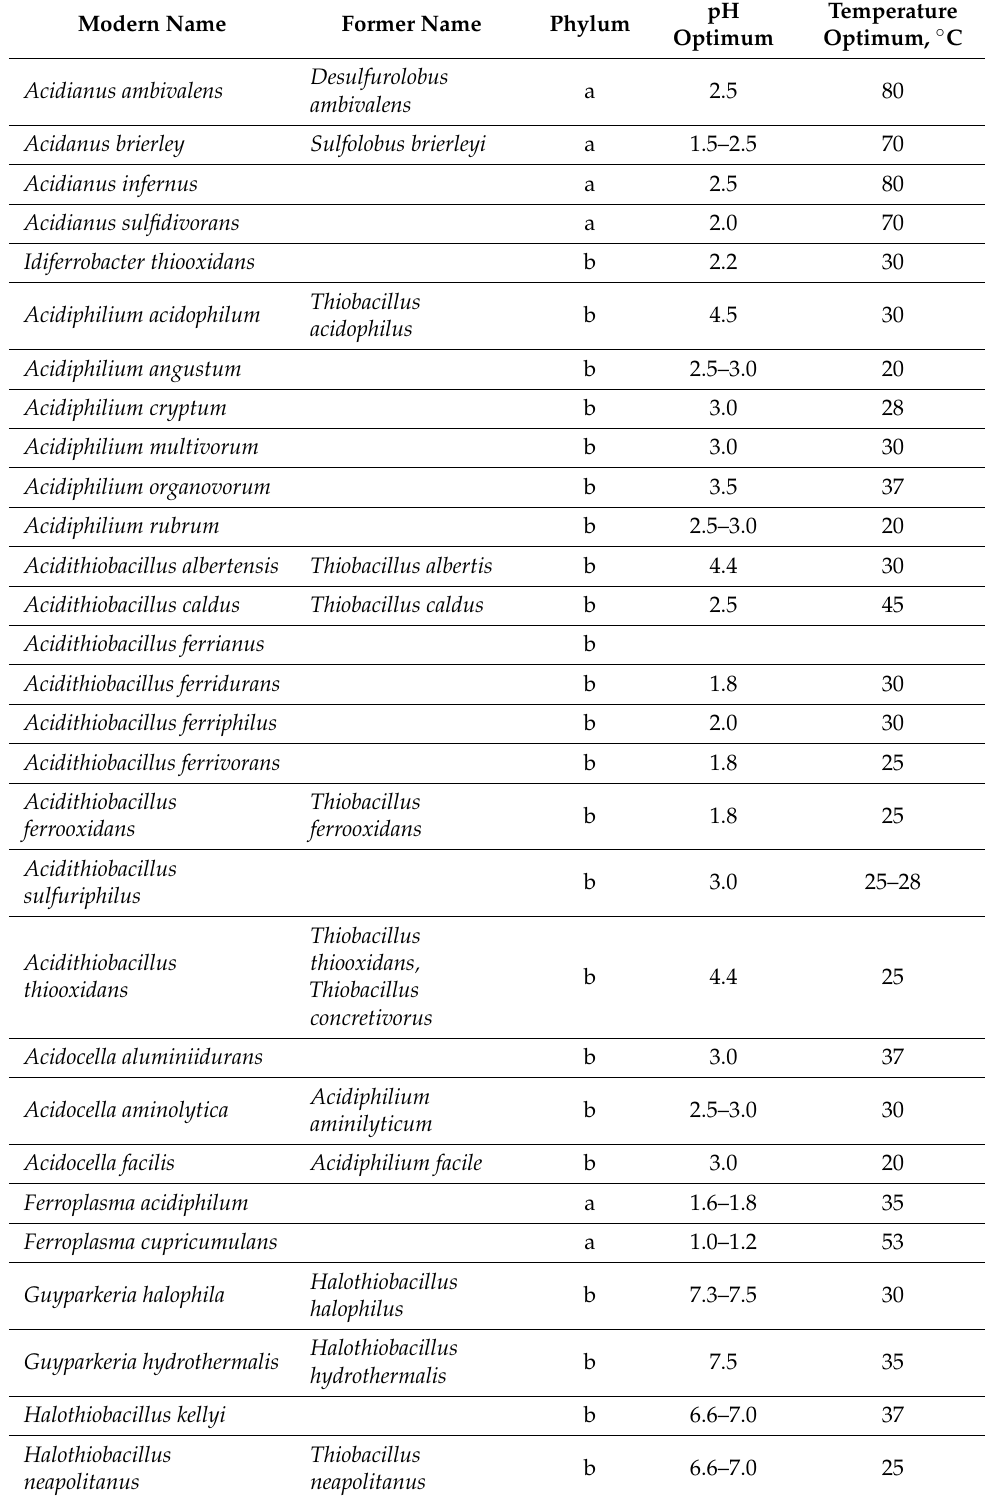
Table 1. Archaeal (a) and bacterial (b) species of the genera whose representatives were used for the acid metals bioleaching